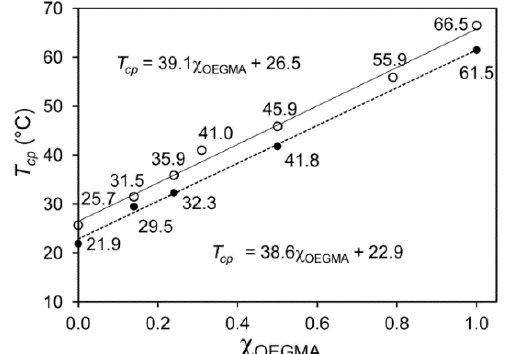
Figure 12. Tcp as a function of OEGMA mol fraction in poly(OEGMA- co -DEGMA) at 2 mg mL − 1 using ( ○ ) distilled water ( R 2 =0.9921) or (●) PBS pH = 6.8 ( R 2 = 0.9972).